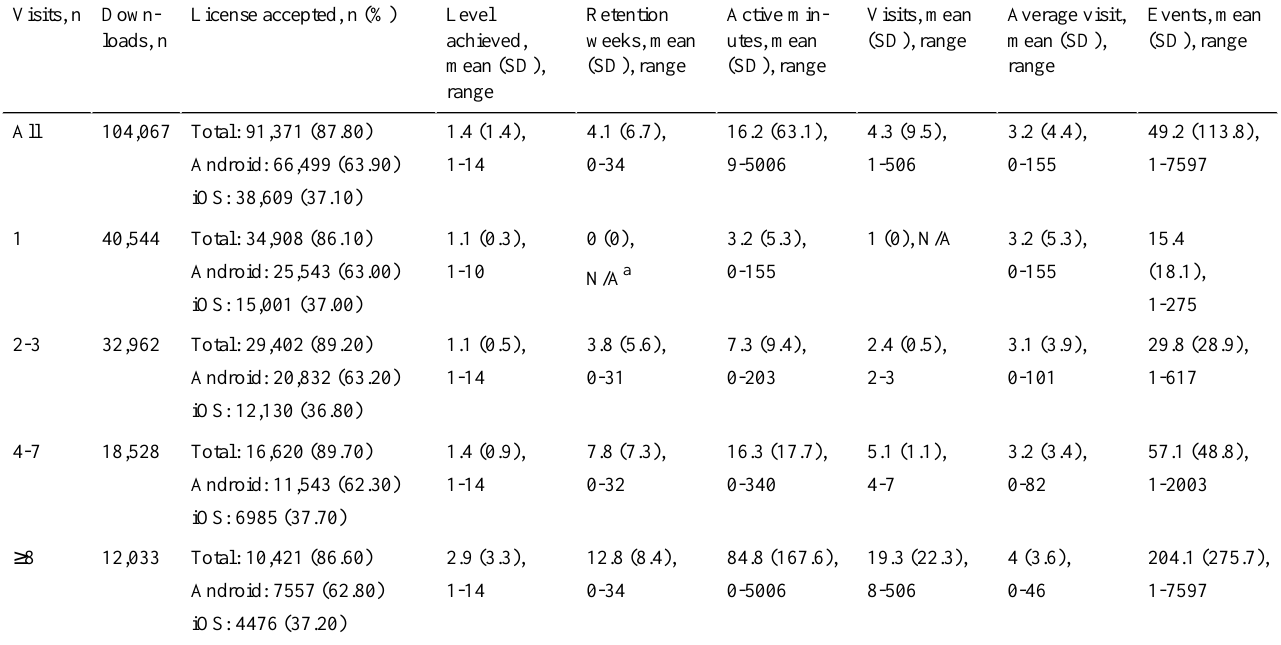
Table 1. Descriptive statistics of use variables by user visits to the app.